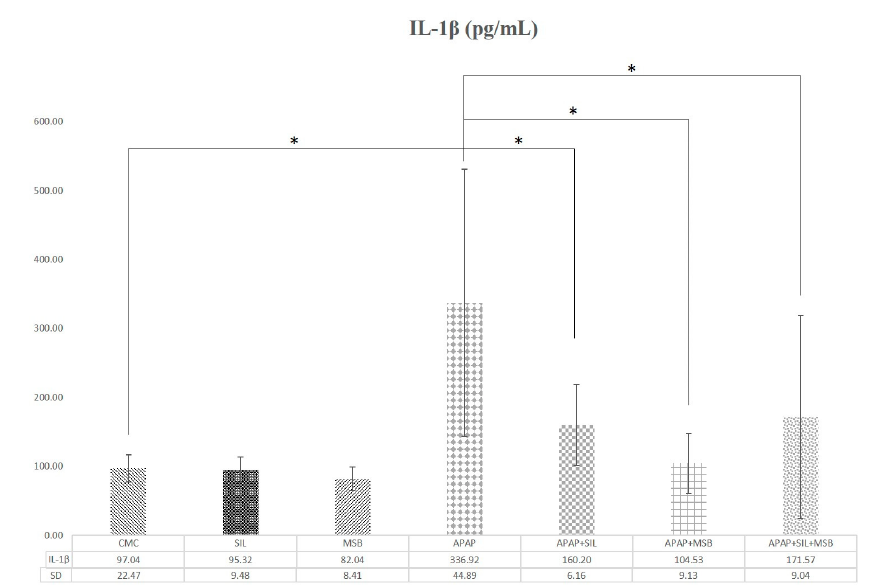
Figure 2. Rats were treated with 1% CMC, SIL, MSB, APAP, APAP + SIL, APAP + MSB or APAP + SIL + MSB. Periorbital blood was collected on Day 13, and the serum was tested for TNF- α ( A ) and IL-1 β ( B ) levels. * Significant di ff erence ( p < 0.05) between groups; data were analyzed using one-way ANOVA. Abbreviations: APAP, N-acetyl-p-aminophenol or paracetamol (acetaminophen); CMC, carboxymethylcellulose; IL-1 β , interleukin 1 β ; MSB, MegaSporeBiotic ™ ; SIL, silymarin; TNF- α , tumoral necrosis factor α